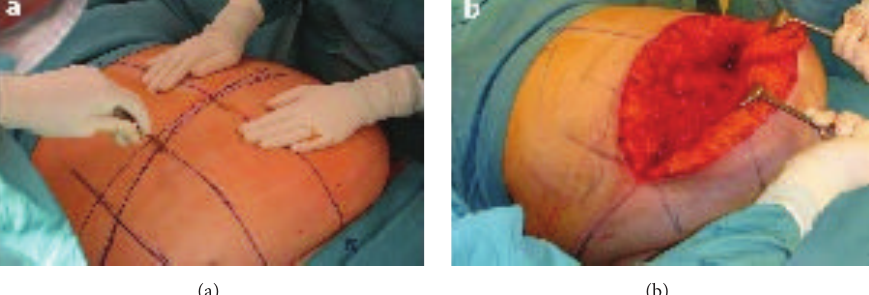
Figure 1: (a) Incision made in the medial two-thirds of the upper horizontal line. (b) Operative field. Mobilization of the dermal-fat flap from top to bottom.